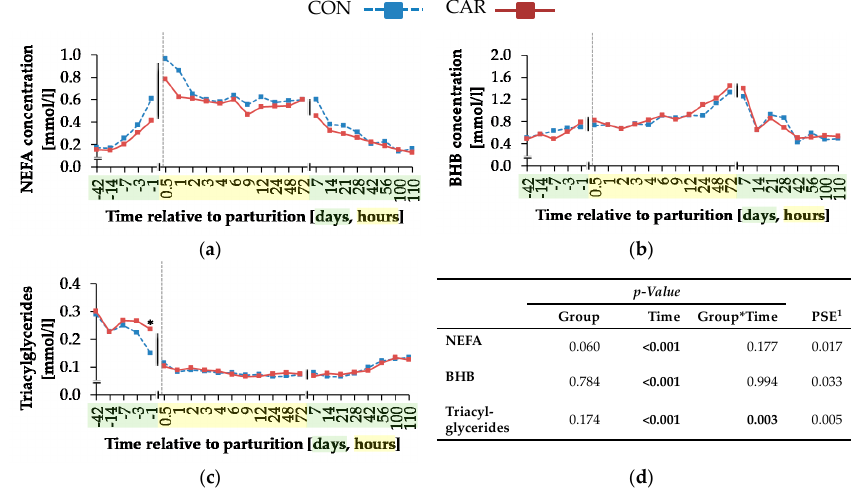
Figure 7. Serum concentrations of ( a ) non-esterified fatty acids (NEFA), ( b ) ß-hydroxybutyrate (BHB) and ( c ) triacylglycerides of cows fed a non-supplemented (CON) or an L-carnitine-supplemented diet (25 g/d from 6 weeks ap up to week 15 pp , CAR). ( d ) Data statistics. Data are given as LS-means. * symbol indicates significant differences between groups in a particular week according to the Tukey– Kramer test ( p ≤ 0.05). 1 pooled standard error.